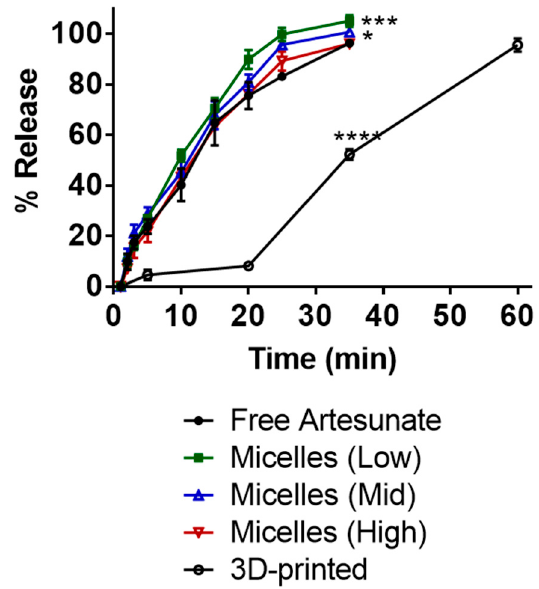
Figure 3. Release profiles of artesunate in PBS (pH 7, 37 ◦ C). At 30 min, free artesunate vs. micelles (mid): * p = 0.0240; free artesunate vs. micelles (low): *** p = 0.0002; free artesunate vs. 3D printed: **** p <